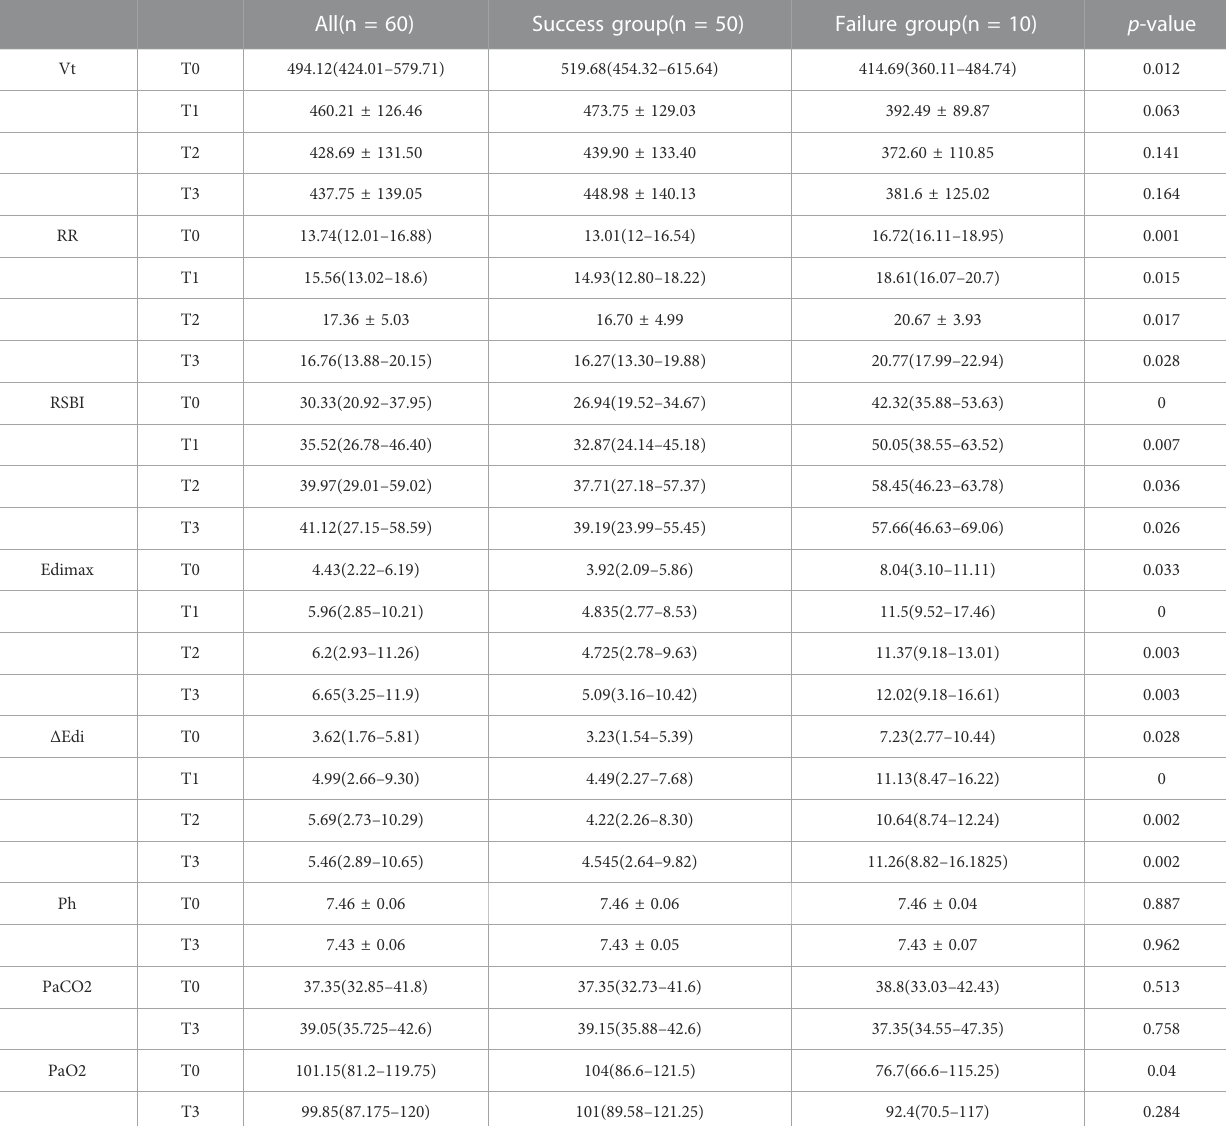
TABLE 2 Respiratory parameters during the baseline and spontaneous breathing trial for all patients. All(n = 60) Success group(n =